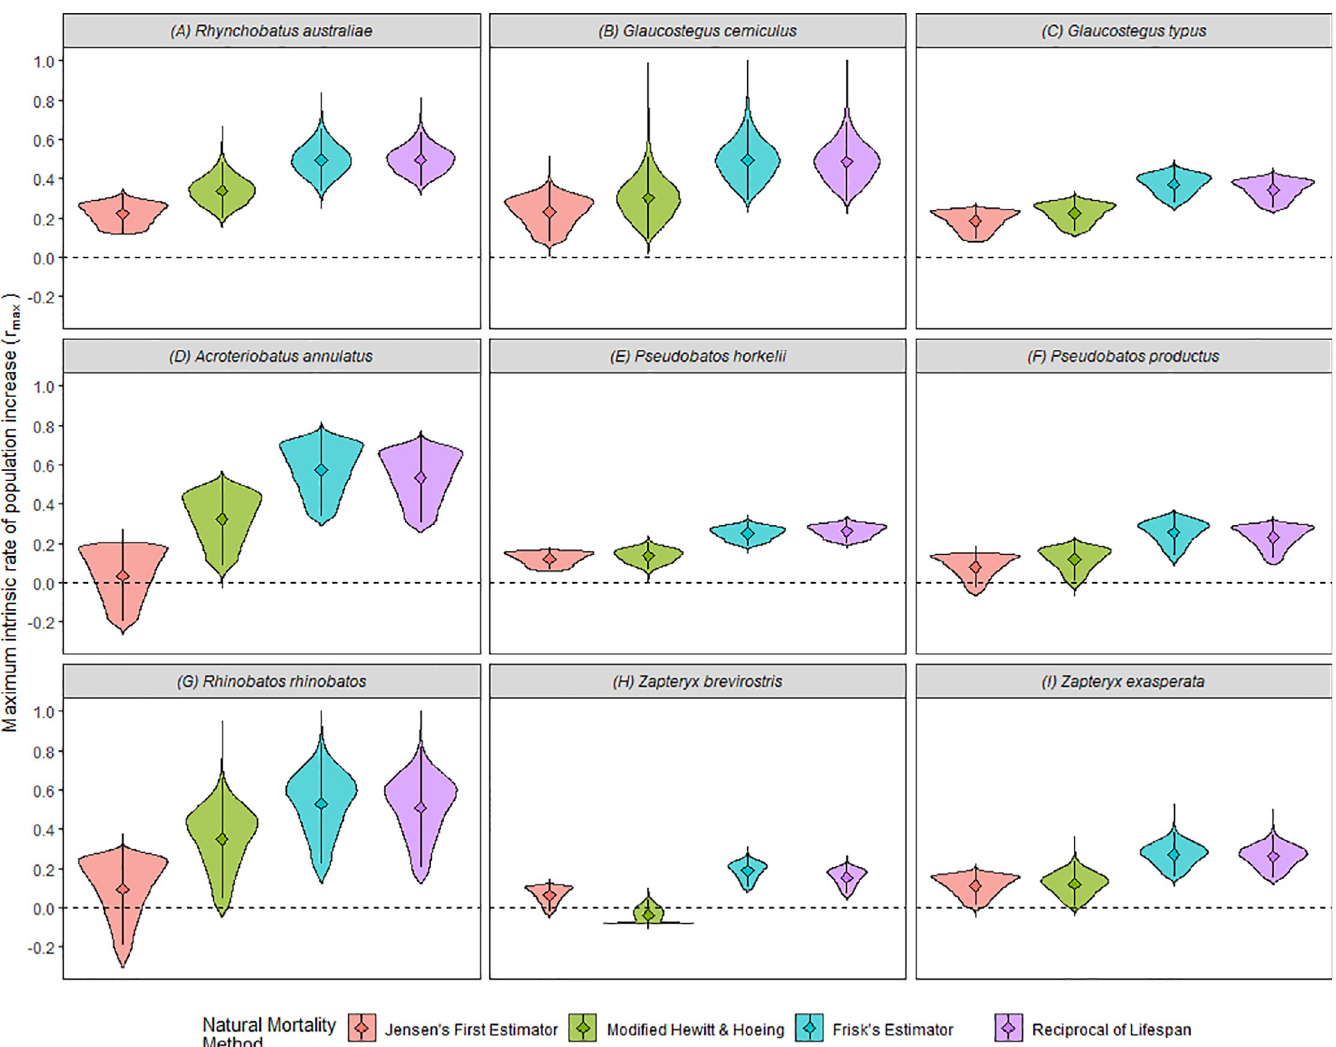
Fig 2. Values of r max (year -1 ) for nine shovelnose ray species vary with different methods of estimating natural mortality. Which are Jensen’s First Estimator (red), modified Hoeing & Hewitt’s Estimator (yellow), Frisk’s Estimator (green), and Reciprocal of lifespan (blue). Means (triangle) and standard deviation (black line) are presented for each method. Species are (A) R . australiae , (B), G . cemiculus , (C) G . typus , (D) A . annulatus , (E) P . horkelii , (F) P . productus , (G) R . rhinobatos , (H) Z . brevirostris , and (I) Z . exasperata . Values below the black dashed line indicate implausible r max